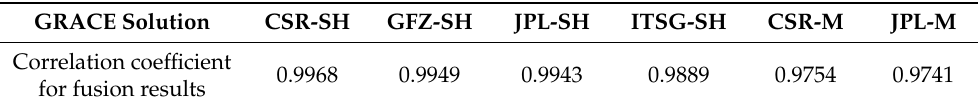
The correlation coefficients between fusion results and TWSC results from six GRACE